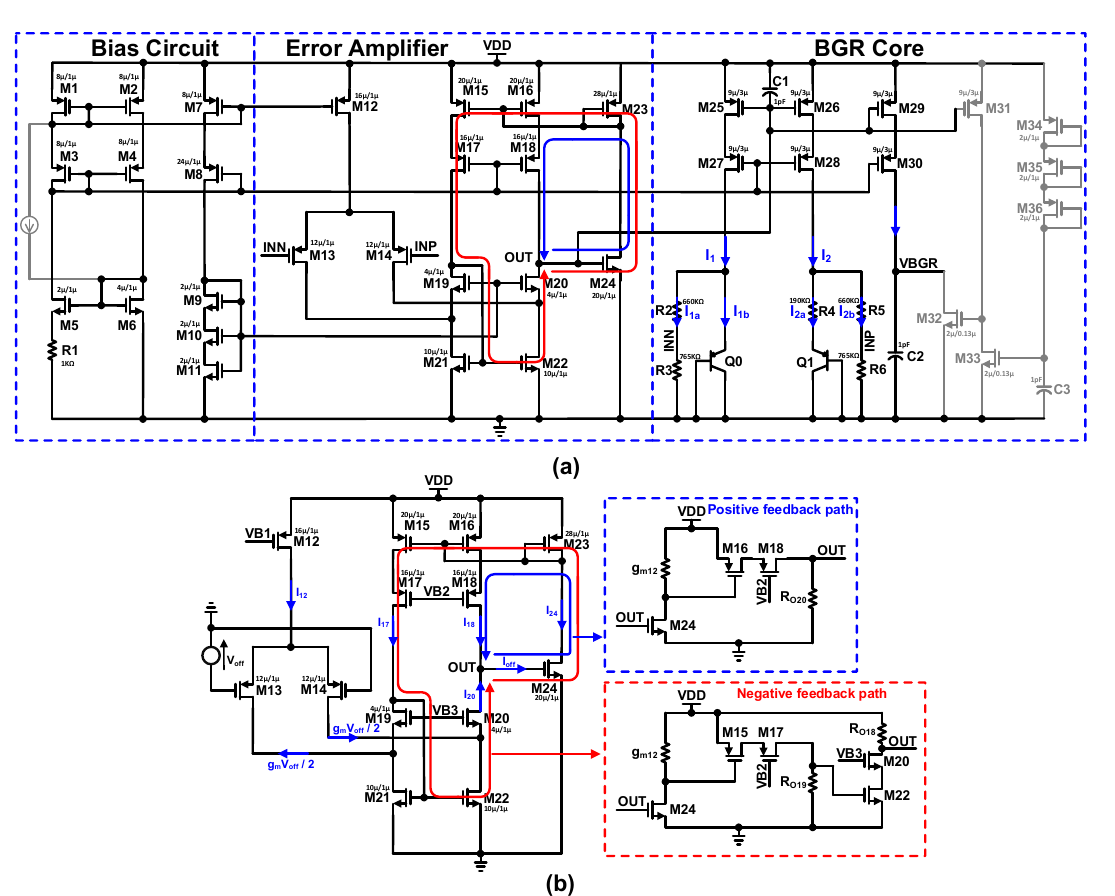
Figure 11. ( a ) Detailed schematic of the proposed error amplifier based bandgap reference voltage generator; ( b ) Proposed folded-Cascoded error amplifier with intentional positive and negative feedback loop.